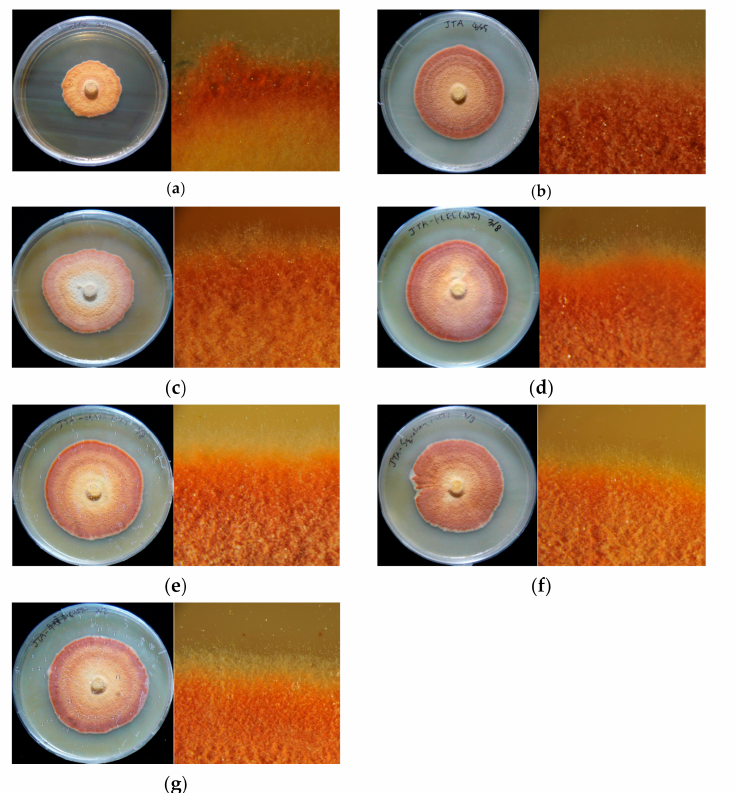
Figure A1. Morphology of colonies of A. camphobrata ACT4. A. camphobrata ACT4 was cultured on ( a ) cPDA medium for 29 days, ( b ) JTA medium for 29 days, ( c ) JTA-squalene medium for 32 days, ( d ) JTA-KLEE medium for 32 days, ( e ) JKLWE medium for 32 days, ( f ) J KFW medium for 32 days, or ( g ) JTA-chitosan medium for 39 days. The morphology of colonies was showed on the left and the view under a stereomicroscope (20 × ) was showed on the